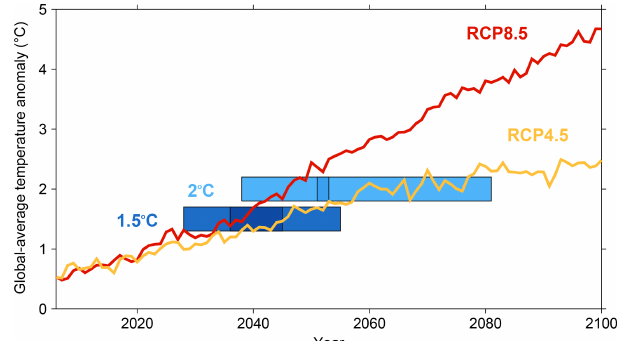
Figure 4. Schematic illustrating the time-slice method. Global- average annual temperature anomalies (relative to 1901–2005 his- toricalNat average) are shown for ACCESS1.3 rcp8.5 and rcp4.5 for 2006–2100. The boxes show the years which are extracted from each RCP to construct the 1.5 ◦ C global warming world (dark blue) and the 2 ◦ C world (light blue). The overlap window between the RCPs is indicated with a darker